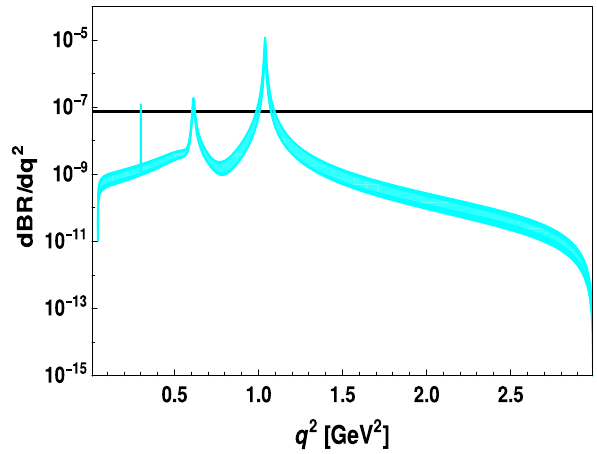
Fig. 2 The resonant contributions to the branching ratio of D + → π + μ + μ − in the SM. The band arises due to the uncertainties in Breit– Winger parameters and the variation of relative phases. The horizontal black line represents the experimental upper bound from